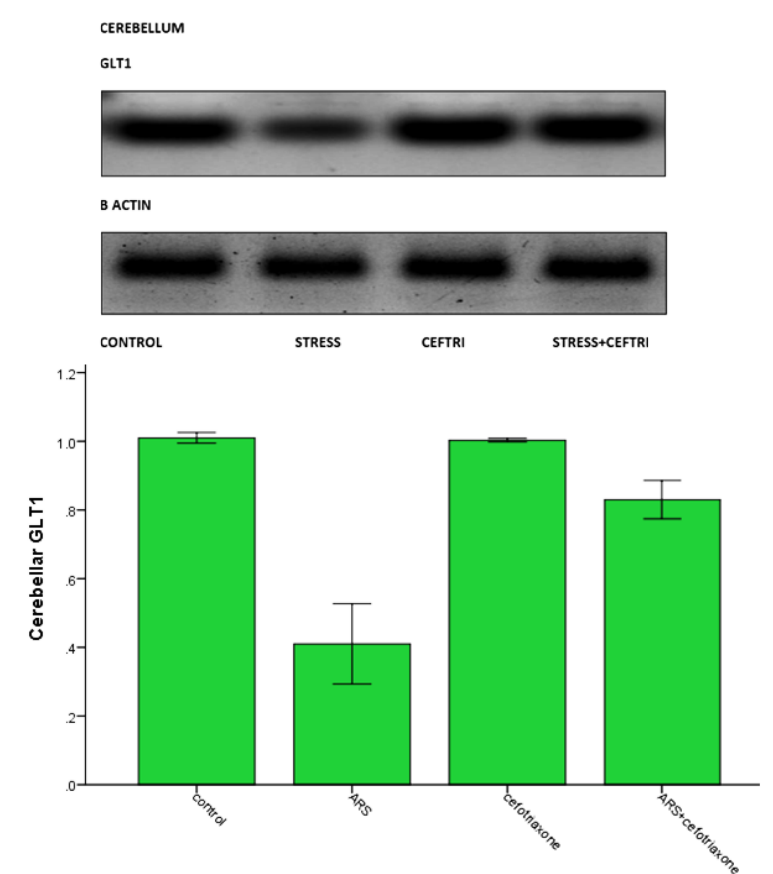
Figure 5. Western blot analysis of cerebellar glutamate transporter 1 expression in the studied groups.